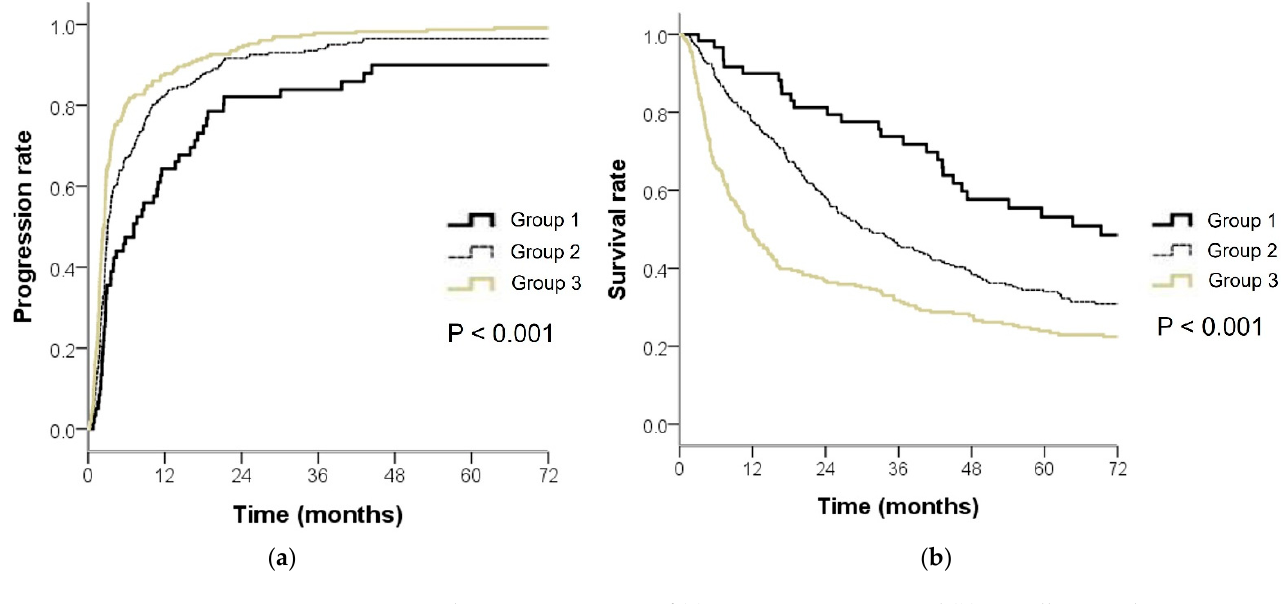
Figure 1. Kaplan–Meier estimates of ( a ) time to progression and ( b ) overall survival in patients with hepatocellular carcinoma after transarterial chemoembolization according to their neutrophil-to- lymphocyte ratio (NLR) and FIB-4 levels. Group 1, NLR < 1.7 and FIB-4 < 3.0; Group 2, NLR ≥ 1.7 and FIB-4 < 3.0 or NLR < 1.7 and FIB-4 ≥ 3.0; Group 3, NLR ≥ 1.7 and FIB-4 ≥ 3.0.